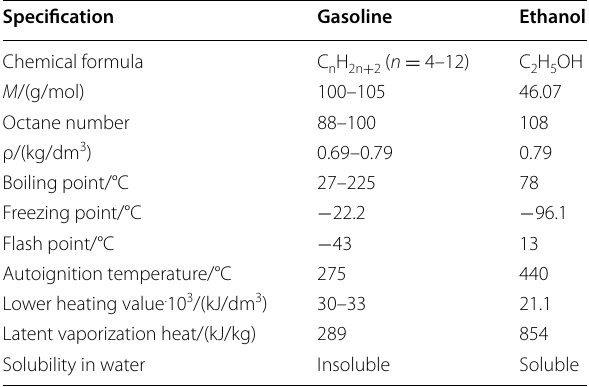
Table 1 The physicochemical specification of gasoline and